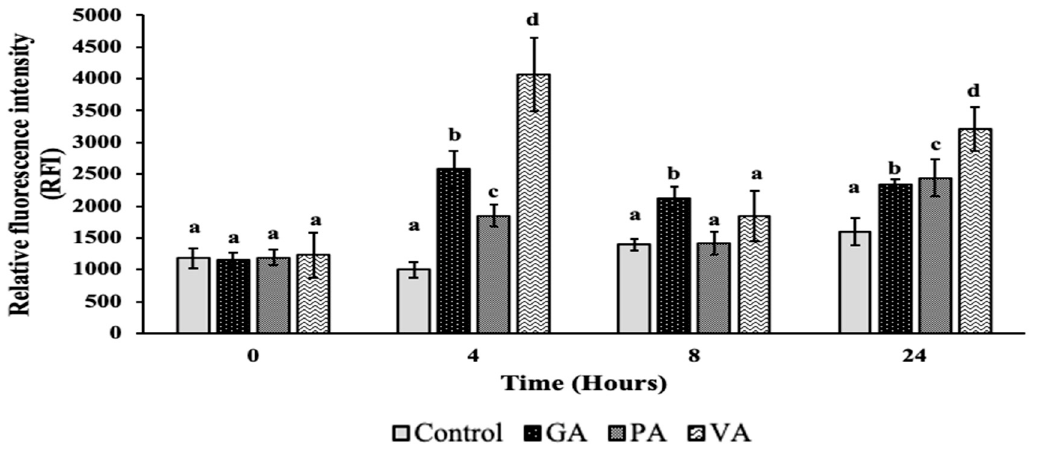
Figure 3. Measuring permeability of cells using fluorescence microplate reader measurements of relative fluorescent intensity (RFI) for untreated and treated ST with GA, PA and VA. Letters ( a – d ) denote significant difference between treatment groups ( p < 0.05).